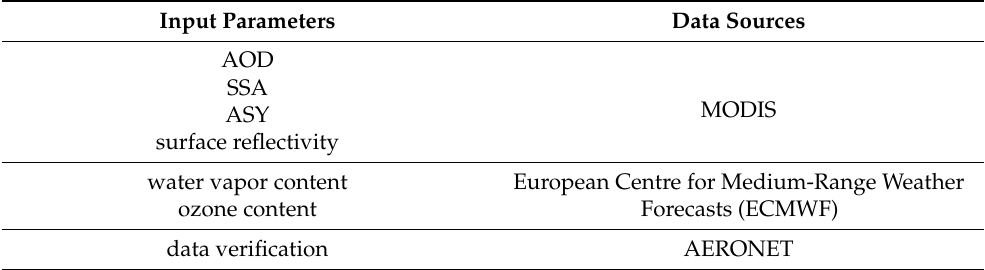
Table 1. SBDART input parameters data source.